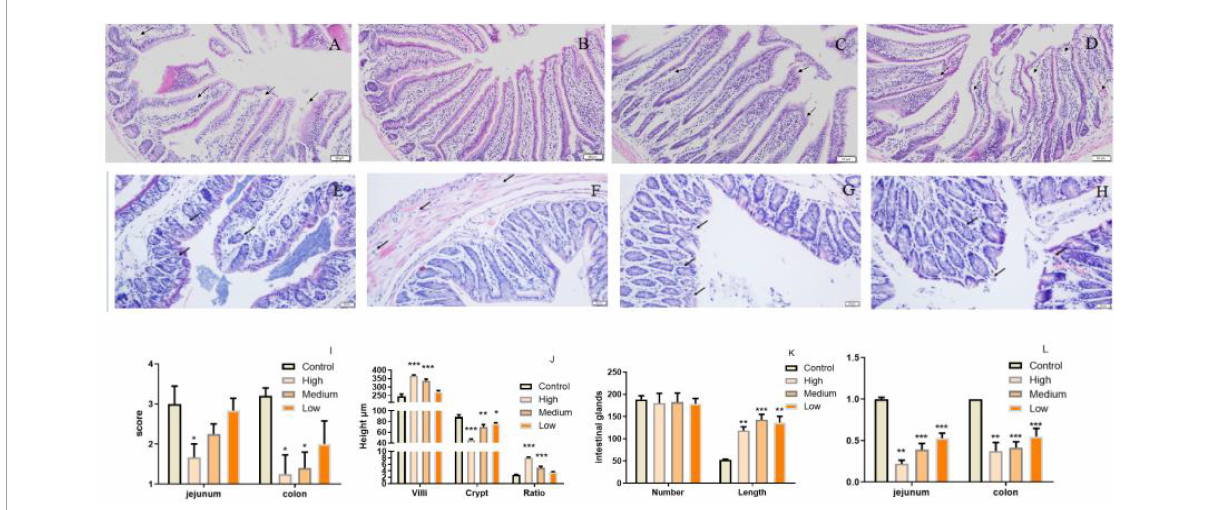
FIGURE4 PSP-NP improves intestinal integrity of aged mice. (A–D) HE stain of jejunum in the control, high, medium and low dose groups, respectively. Arrows indicated the gaps between villi and epithelial cells. It showed that severe shedding of intestinal villi epithelium and gaps at the top of the villi were improved after drug administration. Bar: 200 µ m; (E–H) HE stain of colon in the control, high, medium and low dose groups, respectively. Arrows indicated the epithelium and intestinal glands. It showed that epithelium dysplastic and intestinal glands were improved after drug administration. Bar: 200 µ m; (I) The degree of microscopic injury was evaluated by mucosal and inflammatory conditions from a previously published and wildly used scoring system. The jejunum and colon scores decreased as the concentrations of PSP-NP increased and showed remarkable changes in the high group. (J) The length of villi and the depth of crypt in HE stain slice were analyzed by Image-Pro Plus, and the ratios were compared. PSP-NP increased the villi length and suppressed the crypt depth, thus heightening the ratio of villus length/crypt depth in jejunum. (K) The number and the length of Colonic glands in HE stain slice were analyzed by Image-ProPlus. PSP-NP increased the length of intestinal glands in colon. There was no significant effect on the number of intestinal glands. (L) Gene expression of VIP measured by qRT-PCR in jejunum and colon was significantly reduced in all three doses of PSP-NP. Control indicated control group administrated with saline; and High, Medium and Low indicated high, medium and low dose groups administrated with 200/100/50 mg/kg PSP-NP, respectively. Error bars indicated SEM. N = 8. All data were analyzed by SPSS with the one-way analysis of variance (ANOVA) by LSD test, * P < 0.05, ** P < 0.01, *** P < 0.001, compared with the control group.